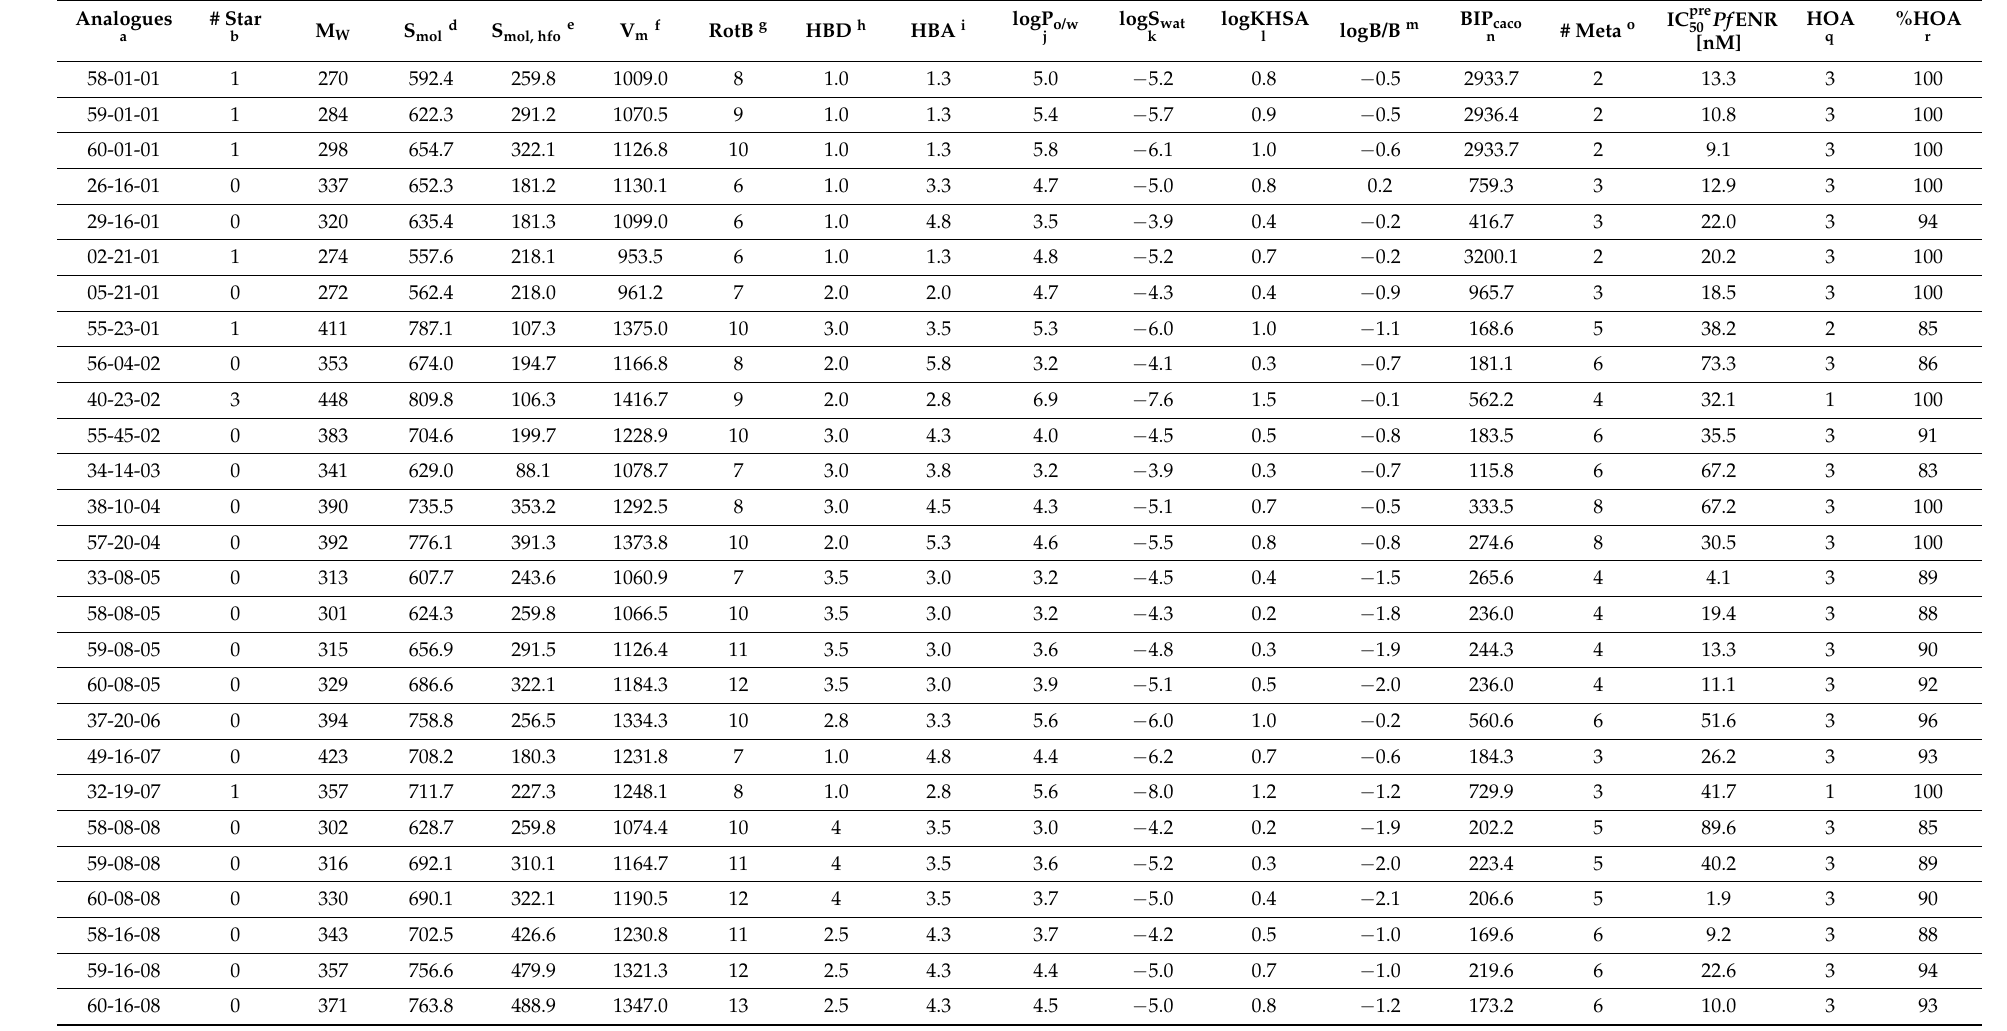
Table 7. ADME-related properties of virtual TCL hits and other reference antimalarial agents computed by QikProp